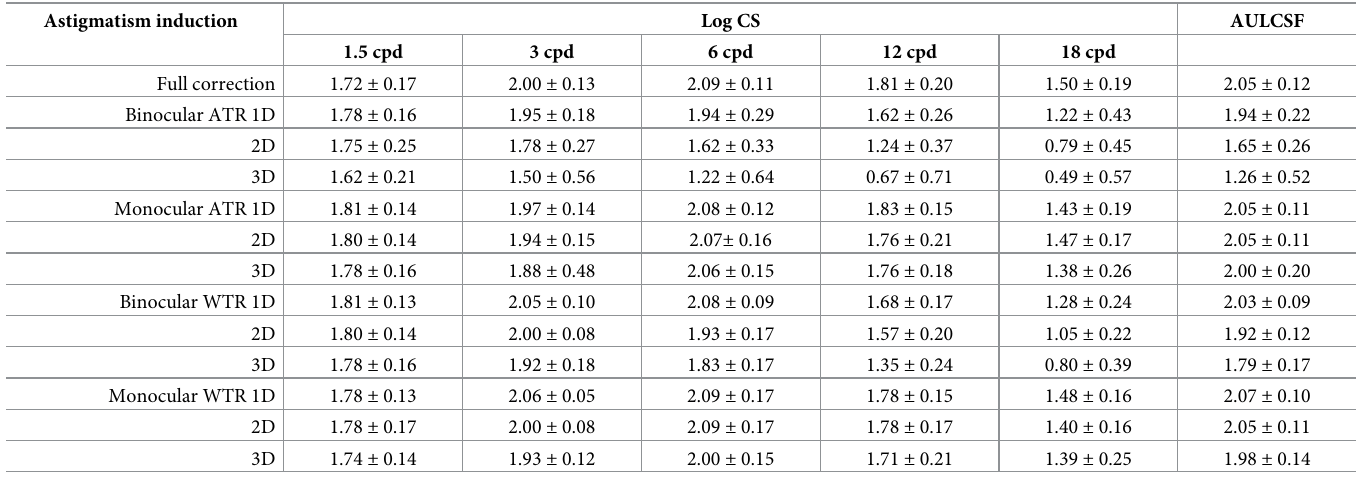
Values are presented as mean ± standard deviation. CS = contrast sensitivity, AULCSF = area under the log contrast sensitivity function, cpd = cycles per degree, D = diopter. ATR = against-the-rule, WTR =